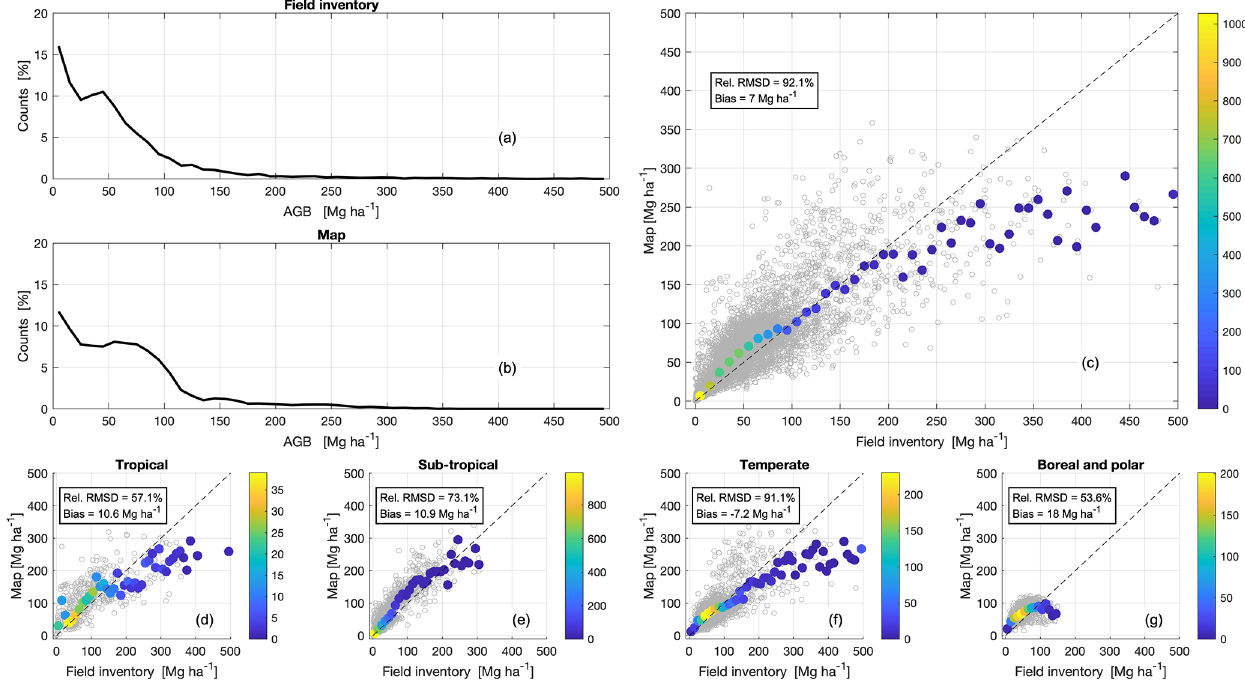
Figure 5. Histograms of AGB from the field inventory database (a) and the map (b) for 0.1 ◦ grid cell values. (c) Scatterplot of map AGB against field inventory values for 0.1 ◦ grid cells (grey circles); the filled circles show the median AGB of the map values in each 10Mgha − 1 wide interval of field inventory AGB values. The colour bar represents the number of grid cells within a given AGB interval. Similar scatterplots are given for the tropical zone (d) , the subtropical zone (e) , the temperate zone (f) , and the boreal and polar zones (g) according to the FAO global ecological zones. On each scatterplot, we report the root mean square difference (RMSD) between map and field inventory AGB relative to the mean value of the reference AGB and the bias, i.e. the difference between mean values of the map AGB and the reference AGB. To improve presentation and because of the paucity of grid cells with AGB above 500Mgha − 1 , axes are truncated at 500Mgha − 1 . Table 2. Total AGB (unit: Pg), forest area (unit: ha), and average AGB (unit: Mgha − 1 ) per continent from this study and from the FAO FRA 2010. The forest area column for the FRA does not account for countries reporting forest area but not AGB. For Asia, North and Central America, and South America, 5%, 1%, and 10% of the forest area did not contribute to the AGB to the FRA. For Africa, Europe and Russia, and Oceania, less than 1% of the forest area did not contribute to the FRA. The total forest area from the FRA is 4 . 033 × 10 6 ha. Continent This